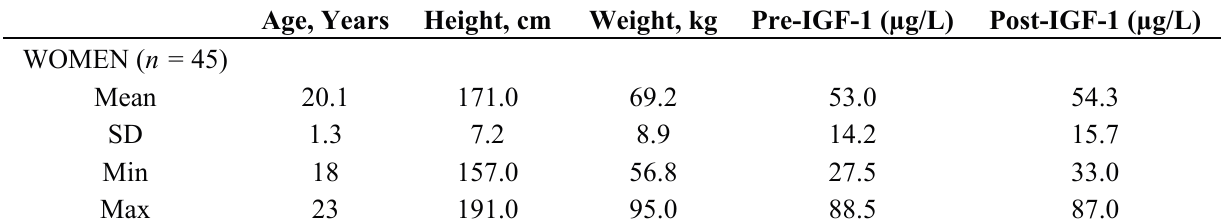
Table 2. Descriptive statistics for